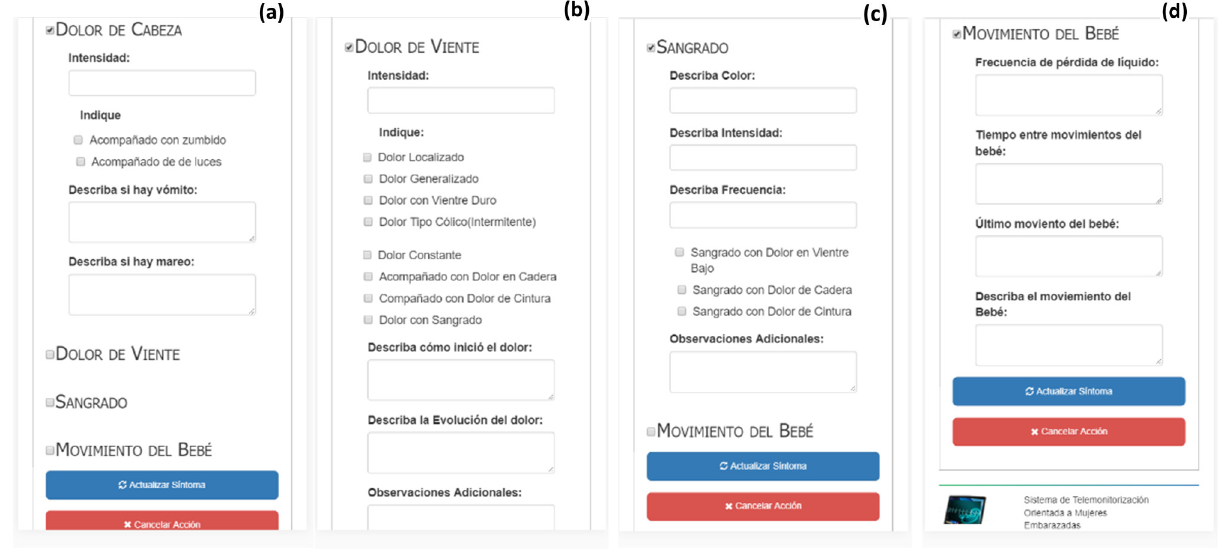
Figure 7. Alarms symptoms (from left to right): ( a ) headache data, ( b ) belly pain data, ( c ) bleeding data, and ( d ) infant movement data.